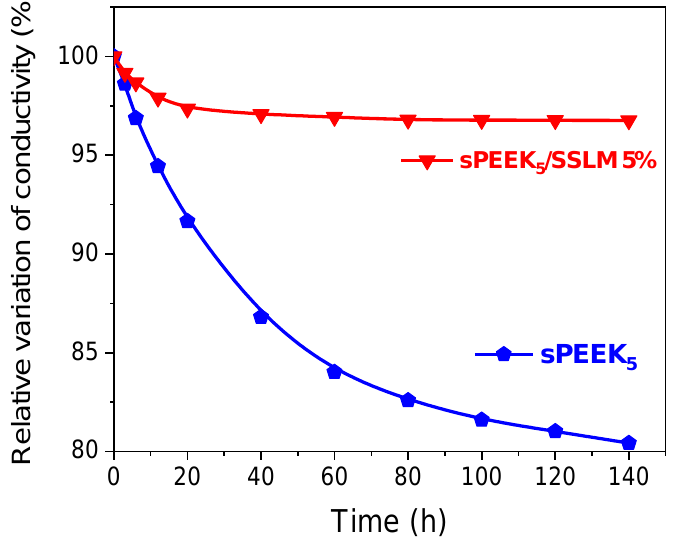
Figure 12. Comparison of the relative decrease of conductivity for the sPEEK and sPEEK / SSLM 5% membranes at 90 °C and 95% RH during 140 h.